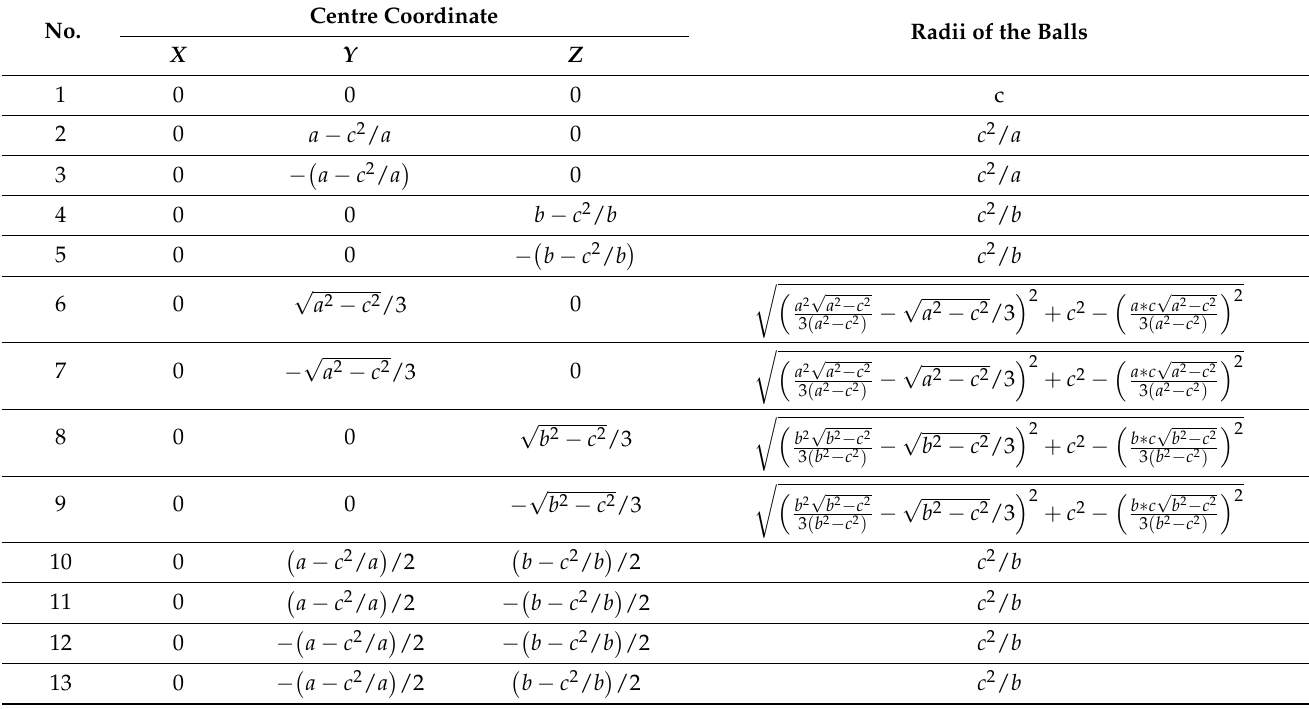
Figure 2. Introduction to the multi-ball modelling approach for the ( a ) five-ball model, ( b ) nine-ball model, and ( c ) 13-ball model. Table 1. No., centre coordinate, and radii of the balls in one soybean particle model. No.